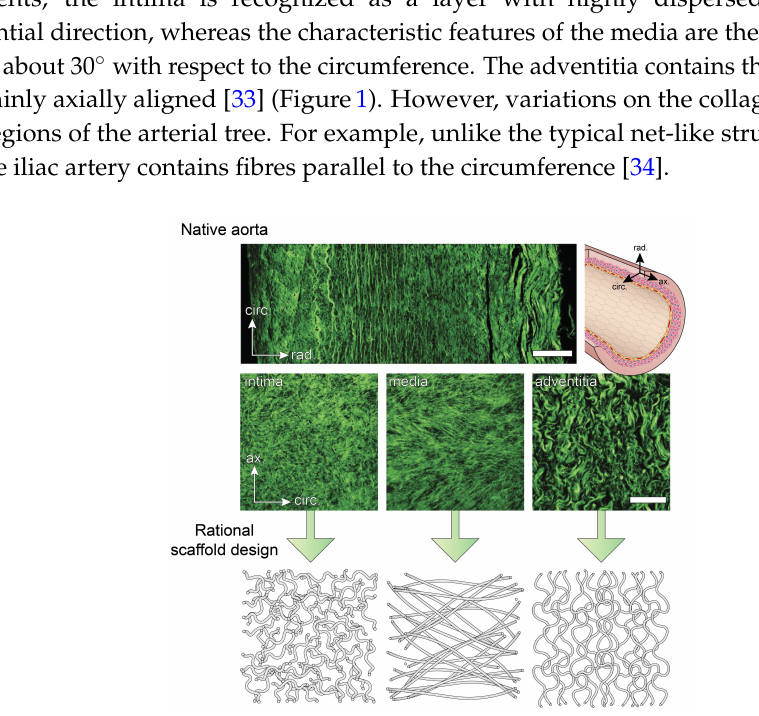
Figure 1. Collagen microstructure of the three different layers of the aortic wall visualized with second harmonic generation microscopy (reproduced with permission from [33]). Mimicking the native collagen organization in fibrous scaffolds should be one of the strategies in the design of instructive scaffolds. Scalebar = 100 µ